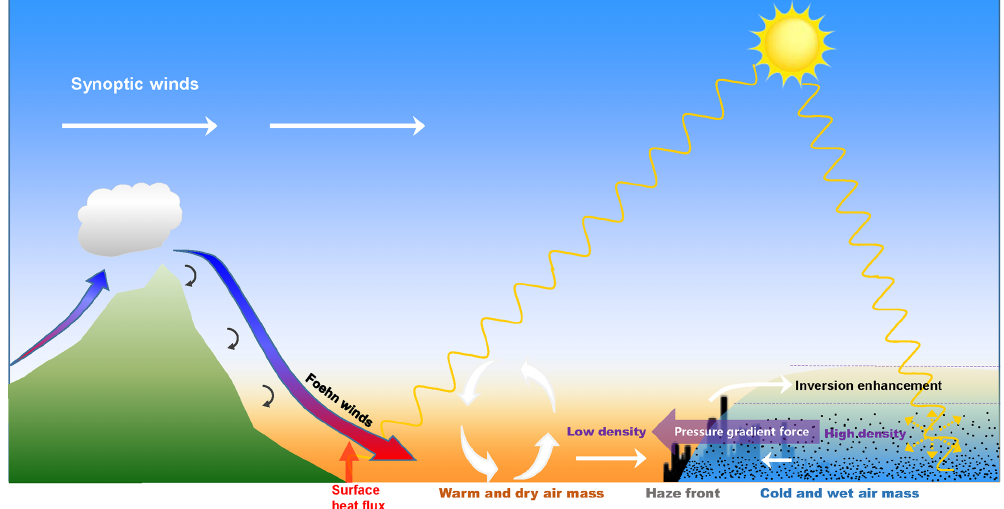
Figure 12. Schematic diagram of the haze front